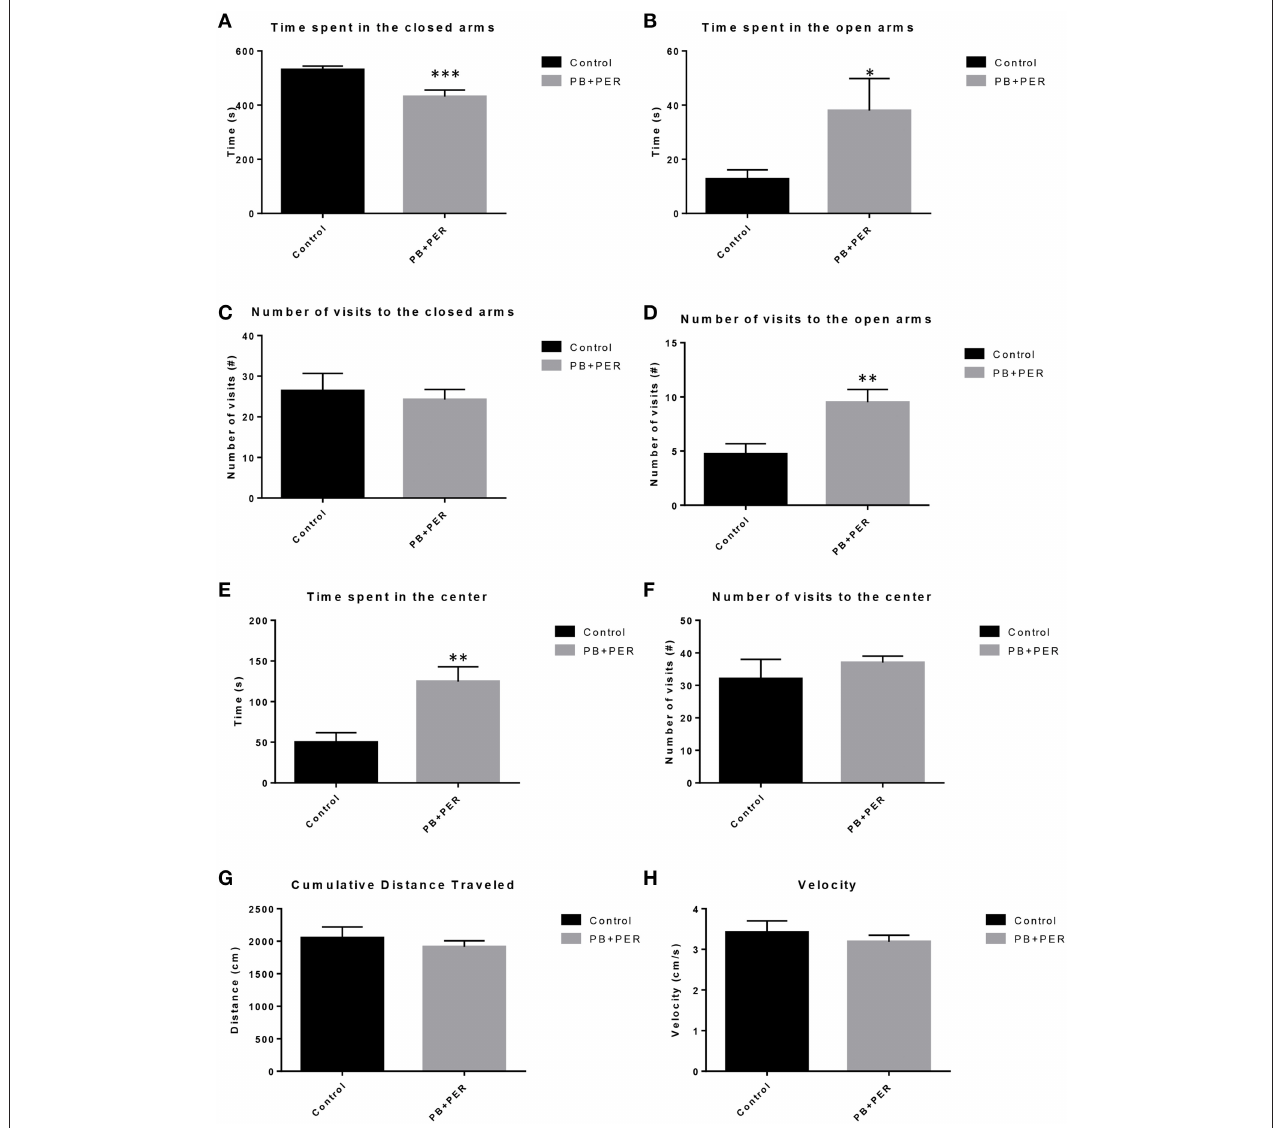
FIGURE 2 | PB + PER exposed mice demonstrated disinhibition, 13 months post exposure, as revealed by Elevated Plus Maze testing. EPM testing revealed that PB + PER mice spent significantly less time in the closed arms (A) , and a significantly larger proportion of time in the open arms (B) as compared to their controls. No differences were noted between the two groups when examining (C) number of visits to the Closed Arms (#). PB + PER mice visited the open arms (#) more times as compared to the control mice (D) . In addition, exposed mice spent more time in the center as compared to the control mice (E) . Therefore, the exposed mice exhibited reduced anxiety-like behaviors. No differences were noted between the two groups when examining the number of visits to the center area (the junction between the closed and the open arms) (F) . Furthermore, EPM testing revealed that there were no differences between exposed and control mice when examining (G) Cumulative distance moved (cm) and (H) Velocity (cm/s). * p < 0.05 ; ** p < 0.01 ; *** p < 0.005 .